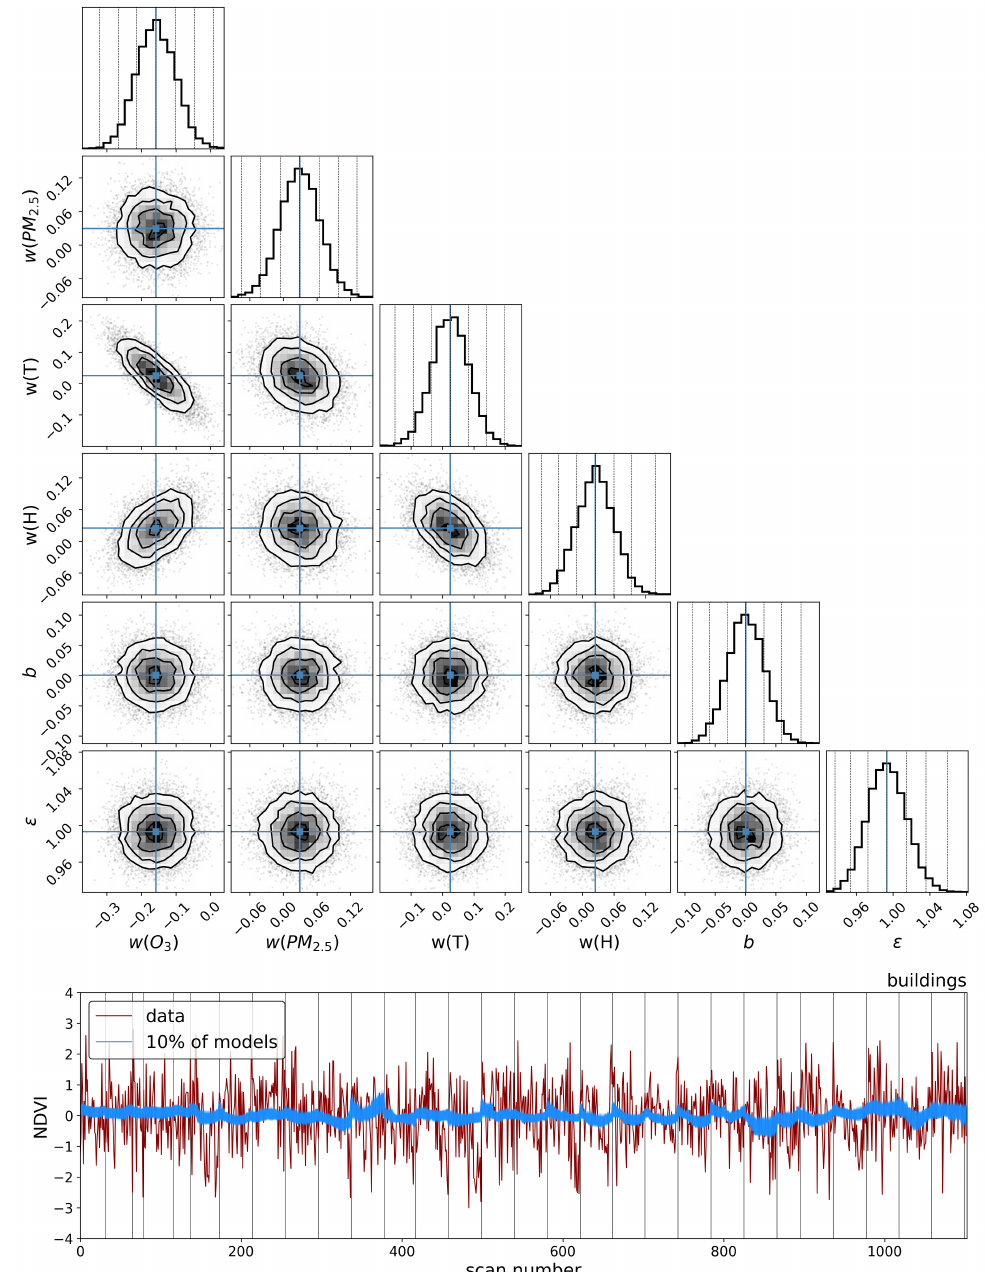
Figure A2. MCMC corner plot of posterior distribution for NDVI of the